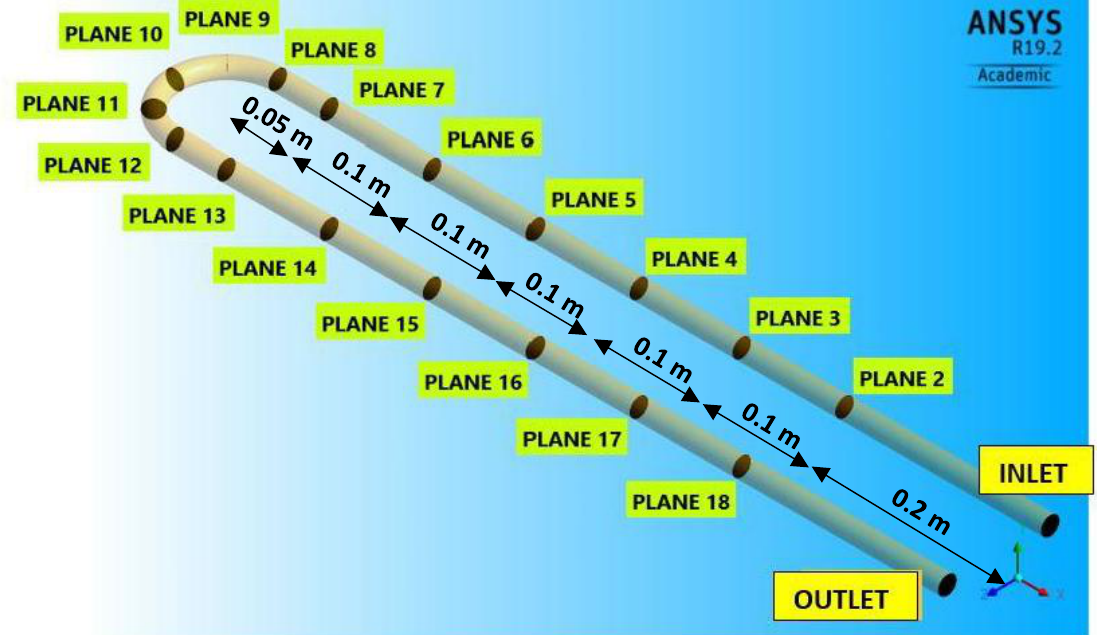
Figure 3. Plane locations along the computational